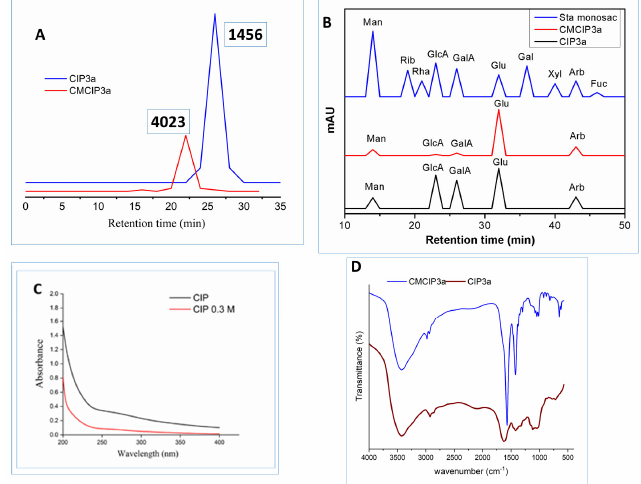
Figure 4. ( A ) HPGPC analysis of CIP3a and CMCIP3a, ( B ) monosaccharide composition of CIP3a and CMCIP3a, ( C ) UV–vis spectrum of CIP3a and CMCIP3a and ( D ) FT ‐ IR spectrum of CIP3a and CMCIP3a. CIP3a and CMCIP3a were hetero ‐ polysaccharides, which had molar percentages of Ara, Man, Glc, GlcA and GalA of 18.61, 17.31, 61.56, 0.45, 2.03 in CIP3a and 15.27, 11.05,